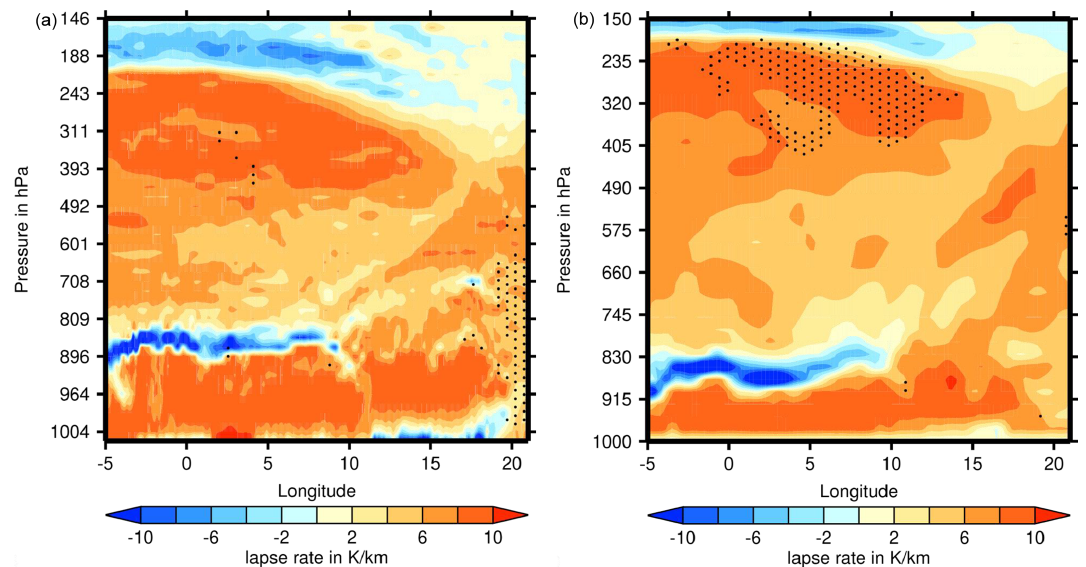
Figure 6. Longitude–altitude plot of atmospheric lapse rates along 52 ◦ N on 21 March 2021, at 18:00UTC. Stippling indicates ice super- saturation, which at temperatures above 235K implies the presence of a mixed-phase or supercooled-water cloud. (a) ICON-EU. (b) ERA5. The vertical axes indicate a mean pressure for each model level